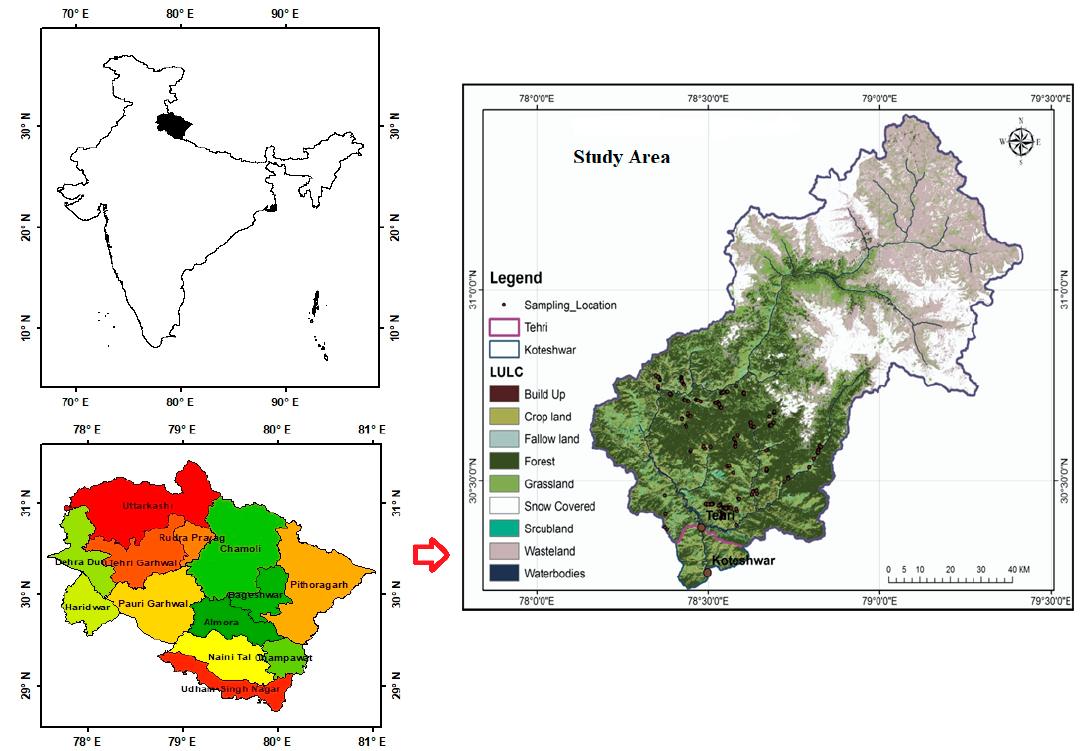
Figure 1. Study area in the high hills of Uttarakhand Himalaya, India.